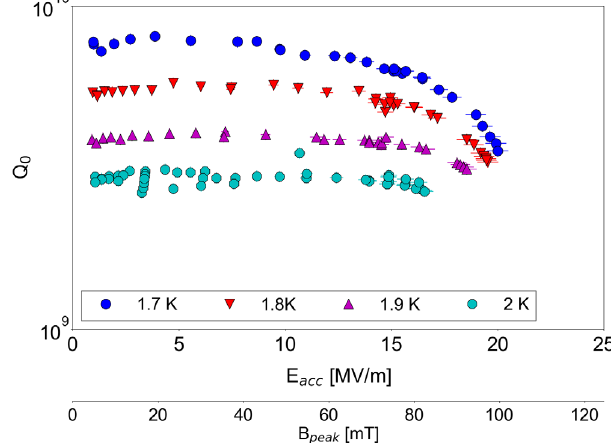
FIG. 2. Power rises for cavity 3HZ021 at different He bath temperatures.